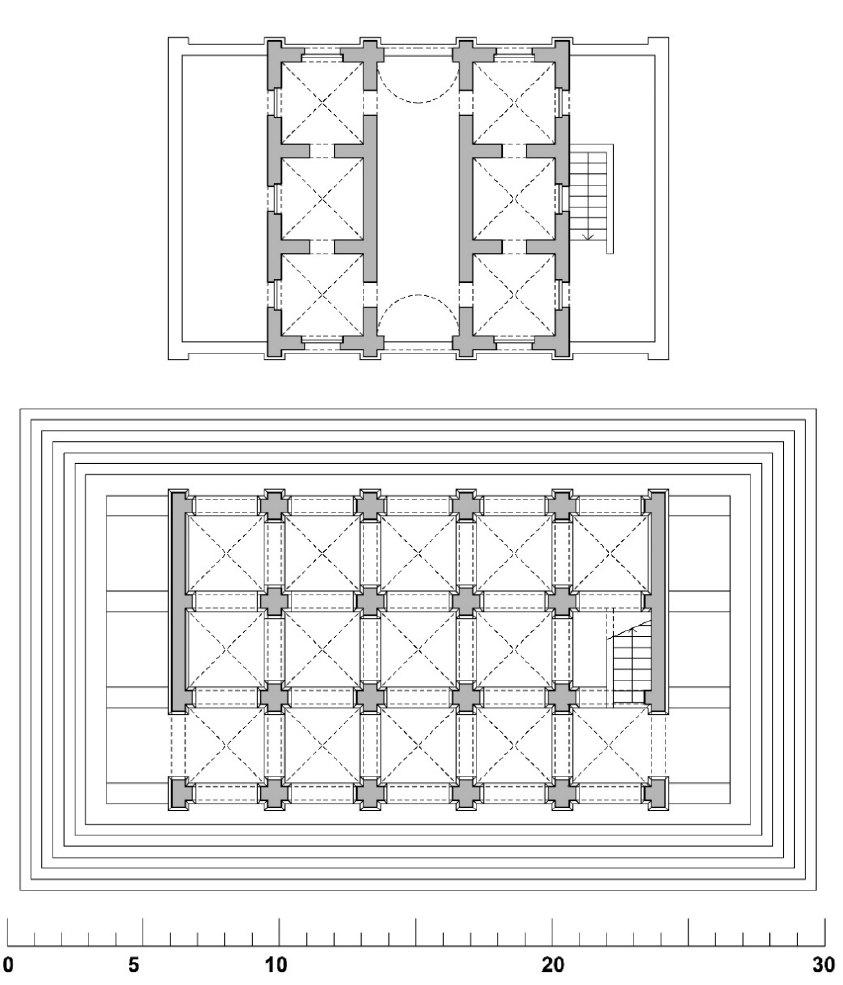
Figure 13. Perspective restitution in the plan of the ground floor and first floor from Pinturicchio (and Raffaello?)’s The Coronation of Enea Silvio Piccolomini, Piccolomini Library, Siena.